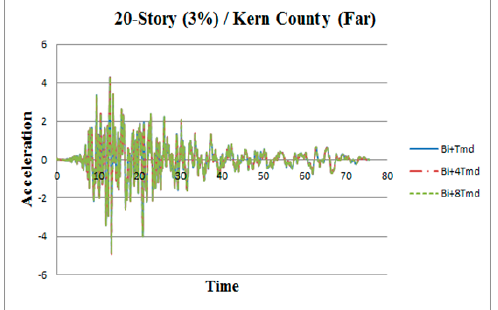
Figure A9. Acceleration time histories for top story of 20-story building under the Kern County (far-fault) earthquake.